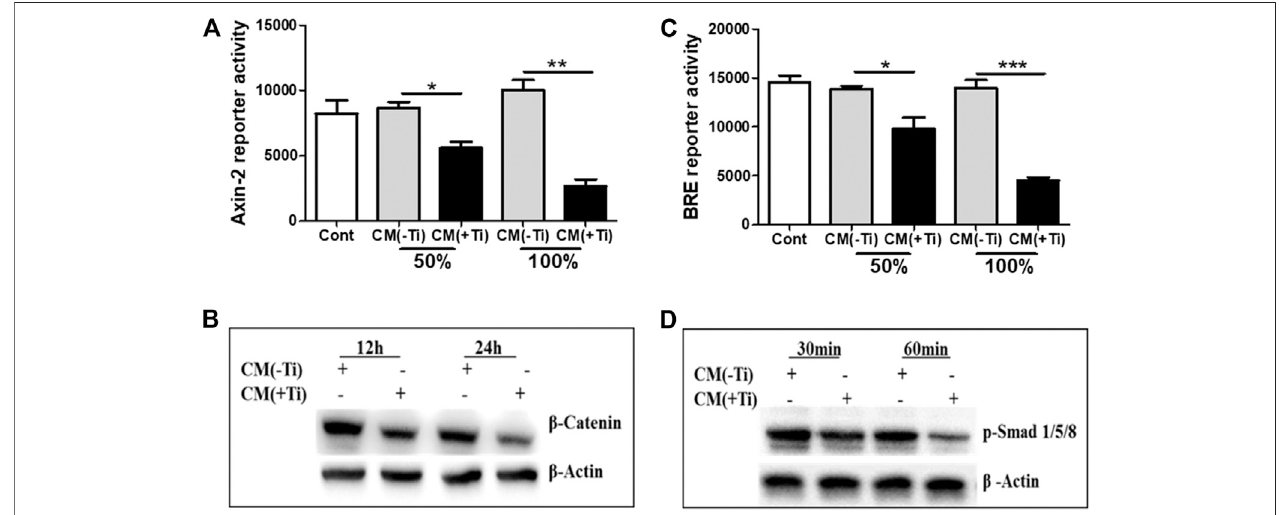
FIGURE 4 | Ti CM suppressed WNT and BMP signaling pathways in osteoblasts. SaOS-2 cells were transiently transfected with the Axin-2 reporter construct for WNT signaling and BREreporter constructs forBMPsignalingand treated withdifferent dosesofTiCM (50and 100%). (A) Axin-2reporter activity and (B) BREreporter activity were performed with collected lysate. (C) Protein expression of β -catenin after 12 and 24 h of Ti CM treatment and (D) protein expression of p -Smad 1/5/8 after 30 and 60 min of Ti CM treatment were evaluated by western blotting. β -Actin is used as a loading control. Data are shown as mean ± SD. Similar results were obtained in three independent experiments. * p < 0.05, ** p < 0.01, and *** p < 0.001 vs.